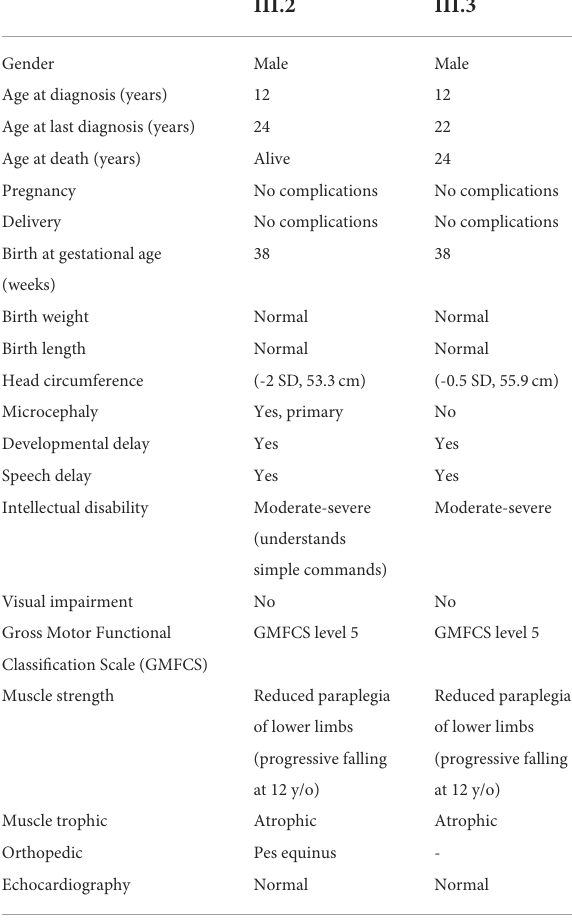
TABLE 1 Clinical phenotype of index patients with biallelic ARHGEF17 variant c.1624C > T